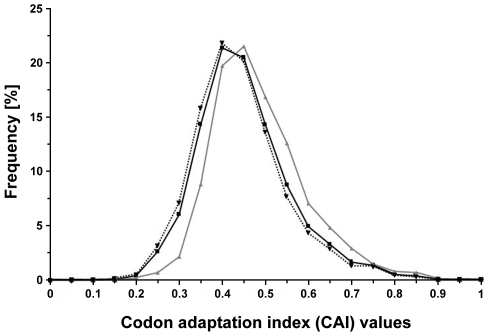
Analysis of the expression of genes encoding predicted CP.Frequency distribution of CAI (codon adaptation index) values, within the entire proteome of E. coli (4243 proteins, dark line), predicted CP (899 proteins, gray line) and predicted non-CP (3344 proteins, dotted line). The 95% confidence intervals of the mean were [0.4474–0.4538], [0.4776–0.4915], and [0.4379–0.4451] for the entire proteome, for carbonylated and non-carbonylated proteins, respectively.